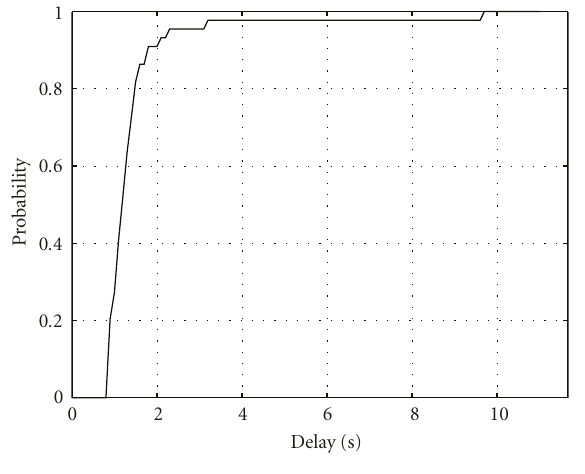
Figure 17: Test alarm delay CDF. Figure 18: Delays for individual test alarms.